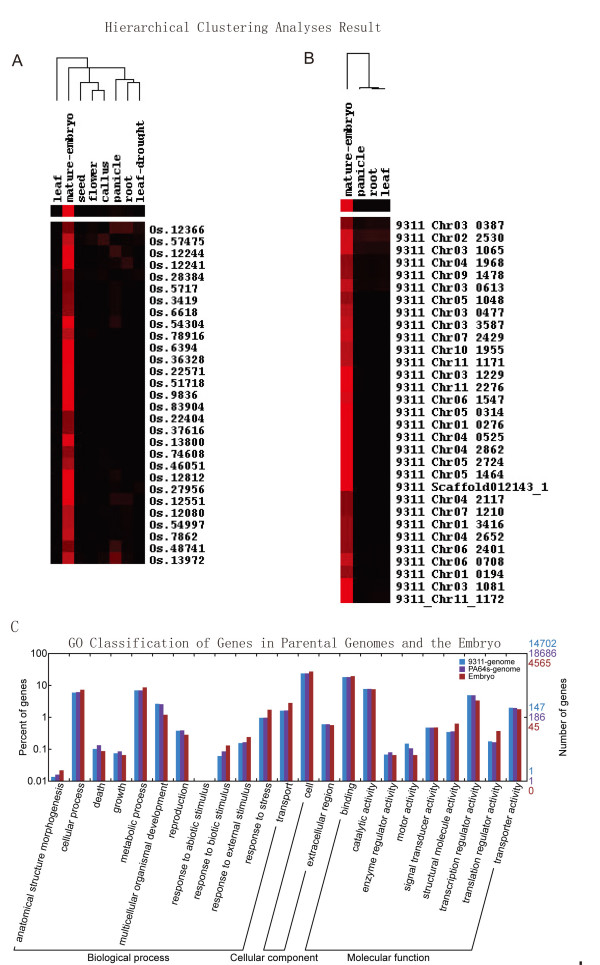
Hierarchical clustering and GO analyses of embryo-associated genes. We summarized our hierarchical clustering analyses (A, compared to NCBI DDD database; B, compared to SAGE data generated from the same hybrid line) of high-abundance genes based on data from the embryo and other tissues (also see Table 5). The expression abundance was normalized to transcript per million. The frequencies of unigenes from different libraries are indicated by color intensity (red), and blank was adjusted to be black. A GO classification of embryo-associated genes in comparison to the genome total (C) was also showed to emphasize the fact that the enrichment of stress- and development-associated genes in the mature embryo.